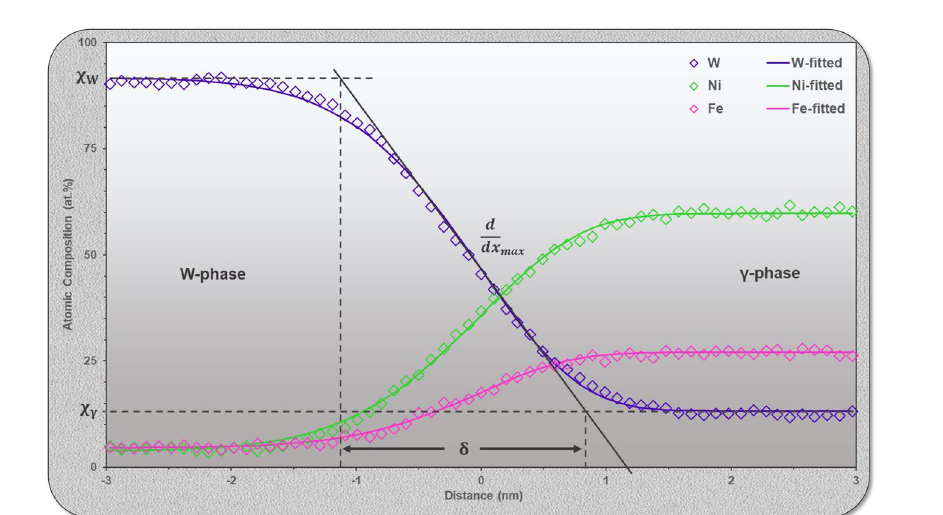
Figure 5. Graphical representation the of gradual chemical transition from W-phase to γ-phase proceeding across the IPB (left to right) from STEM-EDS. W is shown in purple, Ni in green, and Fe in pink. The atomic composition across the IPB has been calculated from the application of a sigmoidal fitting function, providing the bulk concentration of each elemental species in the W and γ-phases ( χ W and χ γ respectively), also leading to the determination of IPB width, δ. This has been shown for only the element W in this